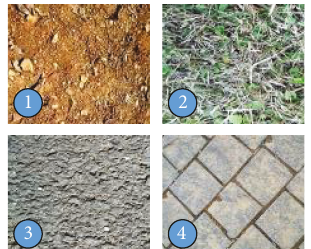
Figure 4: Photos of the traversed terrains.